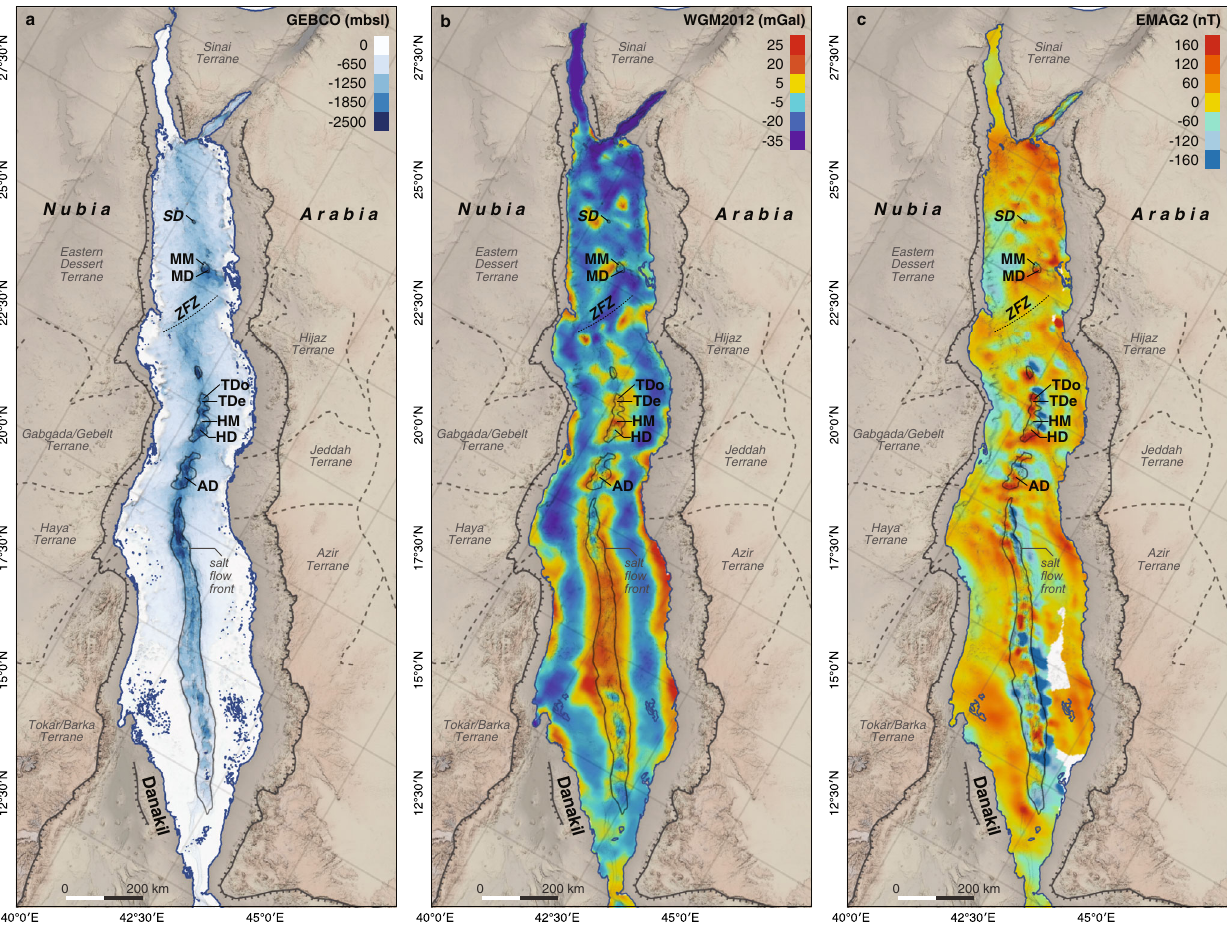
Fig. 1 Overview maps of the Red Sea. a 15-arc-seconds gridded GEBCO 2020 bathymetry (resolution of 435m at 20°N). b Free-air gravity anomalies from global WGM2012 dataset, 1-arc-min resolution (1.7 km at 20°N). c Magnetic anomalies from global EMAG2v3 dataset, 2-arc-min resolution (3.4 km at 20°N). The position of bathymetric deeps and large axial volcanoes discussed in this work are marked. SD = Shaban Deep, MM = Mabahiss Mons, MD = Mabahiss Deep, ZFZ = Zabargad fracture zone, TDo = Thetis Dome, TDe = Thetis Deep, HM = Hatiba Mons, HD = Hatiba Deep, AD = Aswad Dome. All maps were generated with QGIS, projection